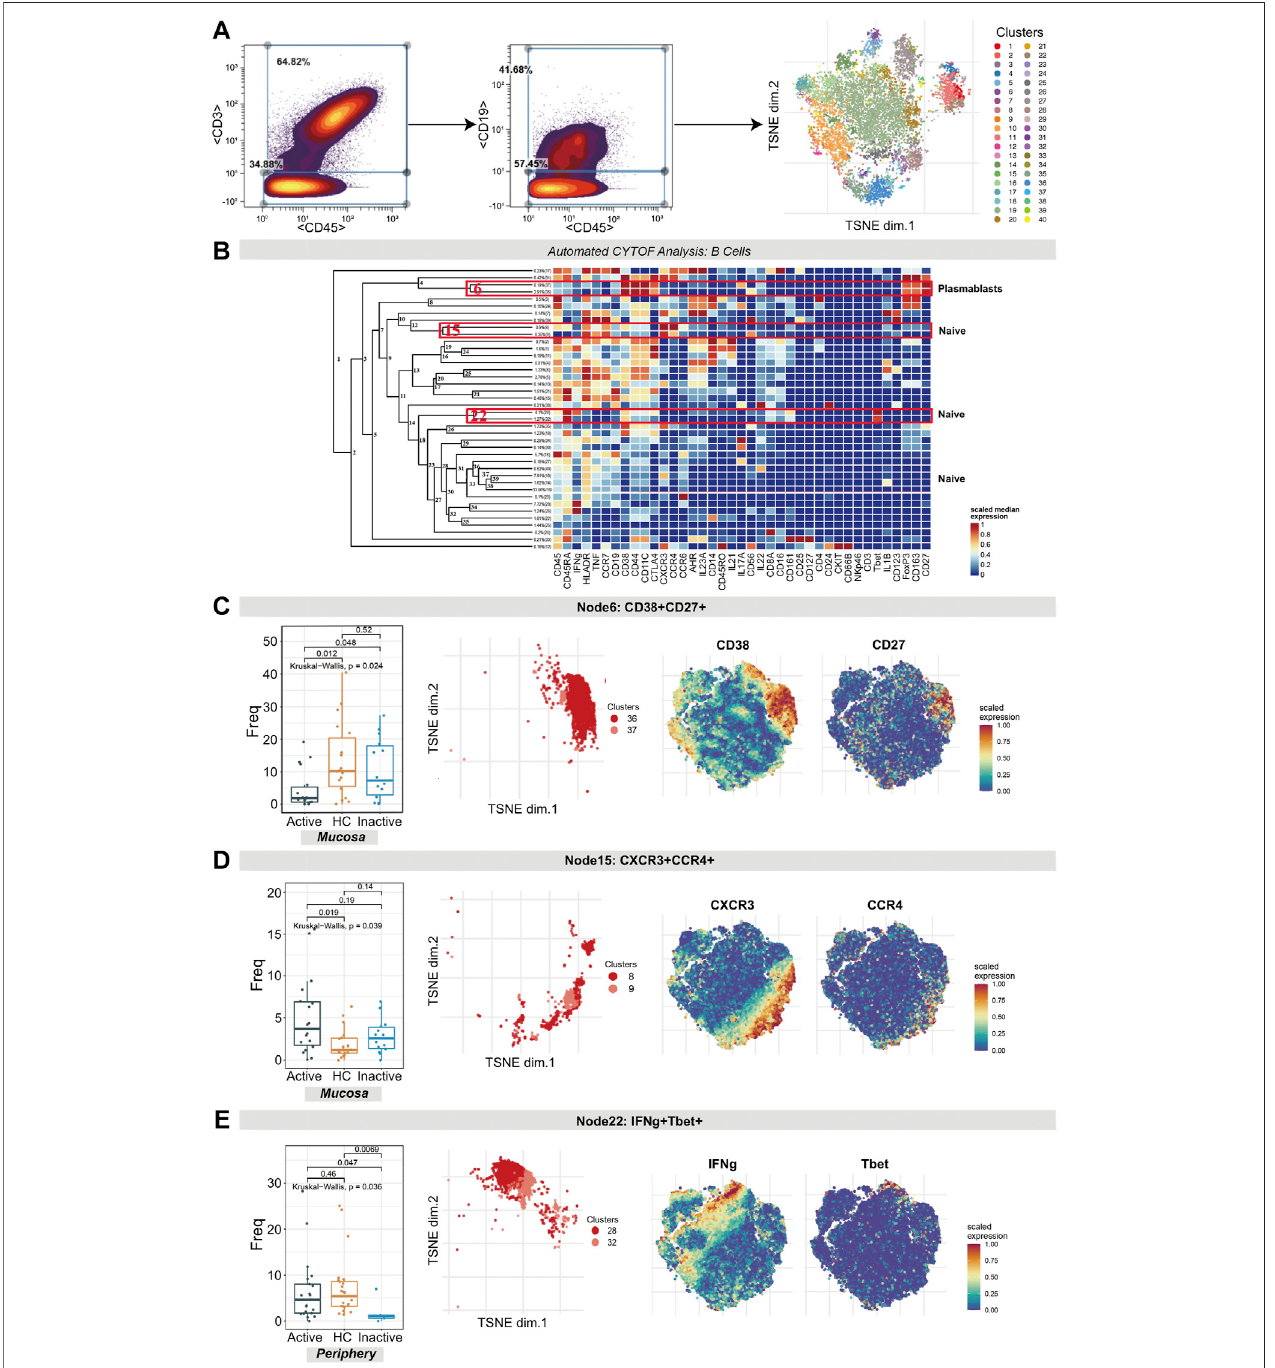
FIGURE3| CyTOF analysisdifferentiated naïveBcellandplasmablast populationsinUCpatientsandHCs. (A) Gatingsteps (left)and t-SNEplot(right) ofselected B cells. (B) Cluster dendrogram, heatmap and selected nodes of B cells. (C – E) Abundance boxplots and t-SNE plots of node 6 (C) , node 15 (D) and node 22 (E) in B cells, with respective selected marker heatmaps for